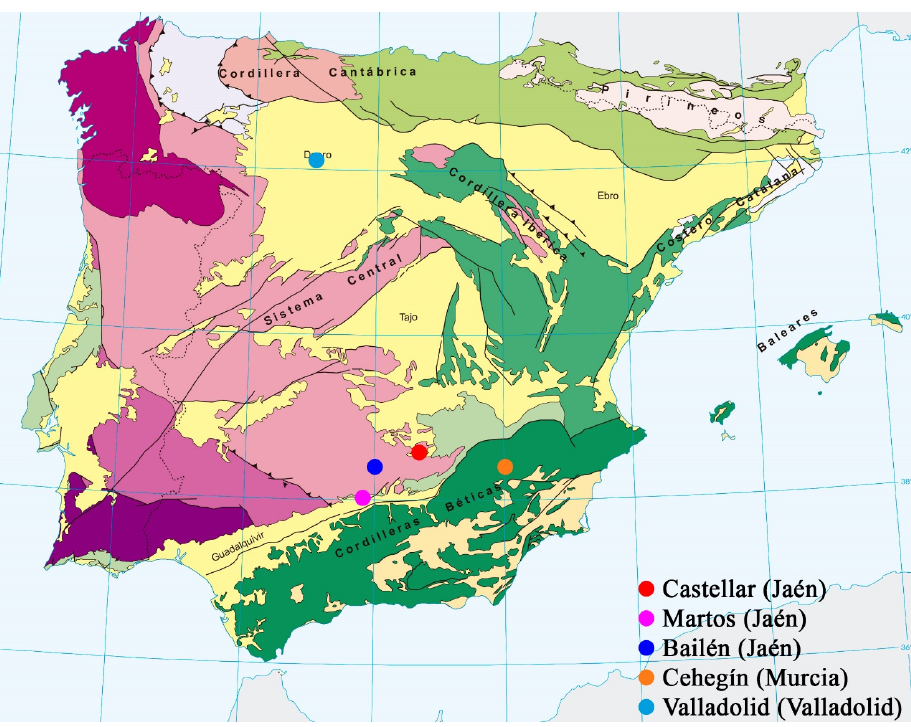
Figure 2. Map of the Iberian Peninsula and the Balearic Islands, showing the main geological units and the location of the points of origin of Spain’s raw materials and industrial waste [20]. In this way, a series of raw materials and industrial wastes have been initially selected, considering both their initial chemical composition and their production capacity. In all the cases, materials are incorporated that, due to their versatility and widespread use, can be found on all five continents. Thus, the main source of CaO will be limestone and marble-cutting sludge. The main source of SiO 2 will be selected clays (yellow, black, and red clays) and the crushed waste material, chamotte. Salt slags from secondary aluminum production (PAVAL) will be used as the Al 2 O 3 content corrector. Finally, gypsum will be used as a setting regulator for the cement